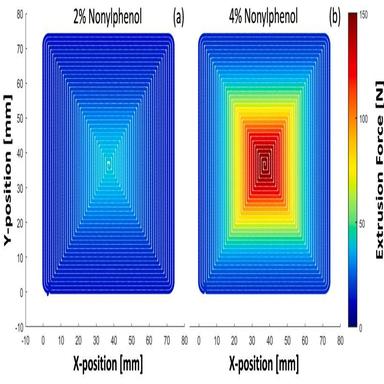
Map of extrusion force as a function of position during printing of an Epon 828/MXD system with 2% (a) and 4% nonylphenol (b).